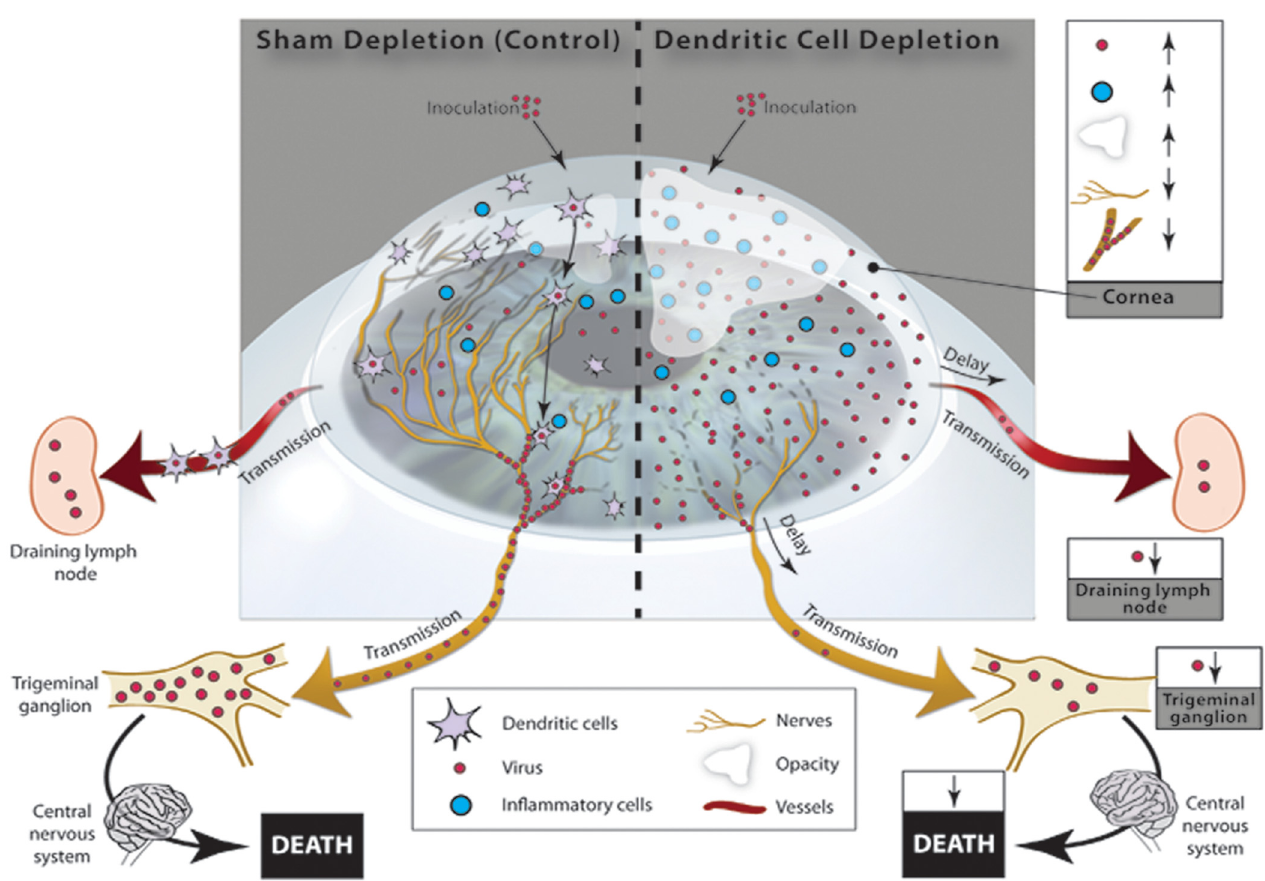
Fig 7. Corneal conventional dendritic cells play a pivotal role in the defense against HSV-1 virus, by reducing local corneal damage and preserving vision, at the cost of mediating systemic viral transmission. HSV-infected corneas demonstrate local viral replication, increased inflammatory cell infiltration, and corneal nerve damage, resulting in keratitis and corneal scarring. Infection of corneal nerves by HSV-1 may directly or indirectly be mediated through cDCs, resulting in transmission of the virus to the systemic compartment, including TGs, dLNs and the CNS, resulting in latency, or death. However, depletion of corneal cDCs results in increased viral proliferation, corneal inflammatory cells infiltration, nerve damage, and increased keratitis severity, scarring and blindness. Further, there are decreased corneal nerves infection, resulting in delayed and decreased systemic viral transmission to TGs and dLNs, and subsequent decrease in mortality. Collectively, corneal cDCs reduce local corneal damages and preserve vision after HSV infection, at the cost of mediating systemic viral systemic transmission resulting in